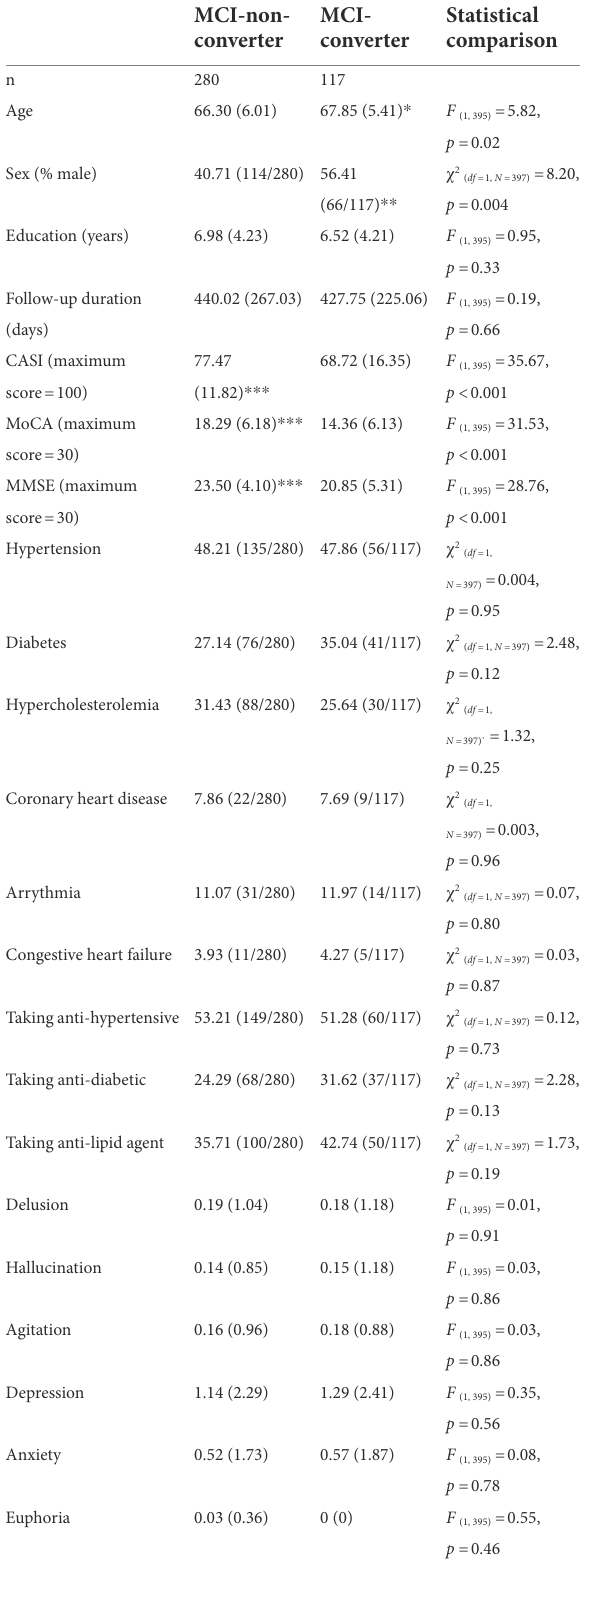
TABLE 3 Demographic and clinical characteristics of patients with MCI under 75 years of